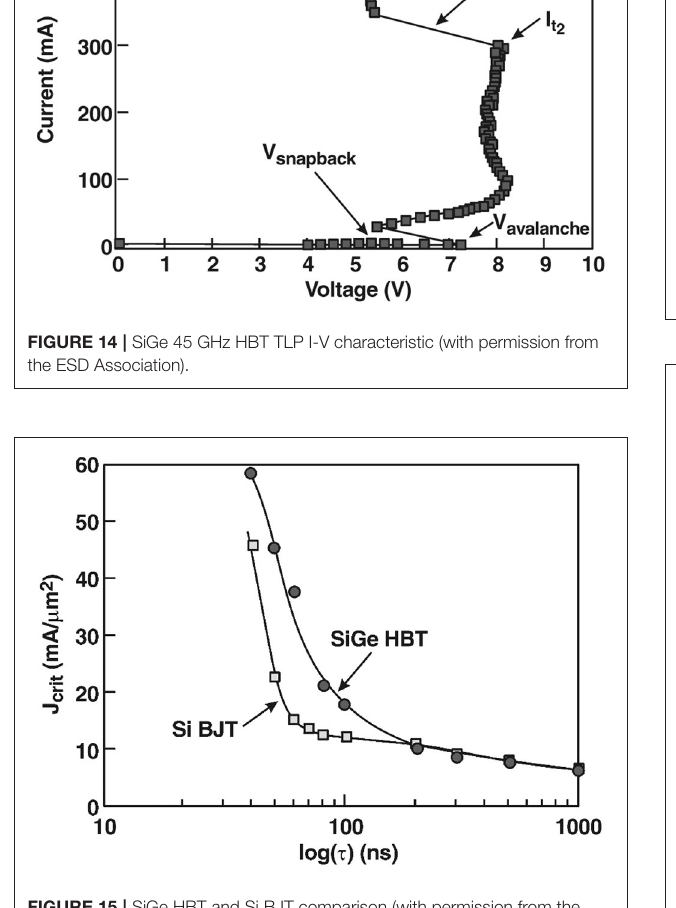
FIGURE 15 | SiGe HBT and Si BJT comparison (with permission from the ESD Association).